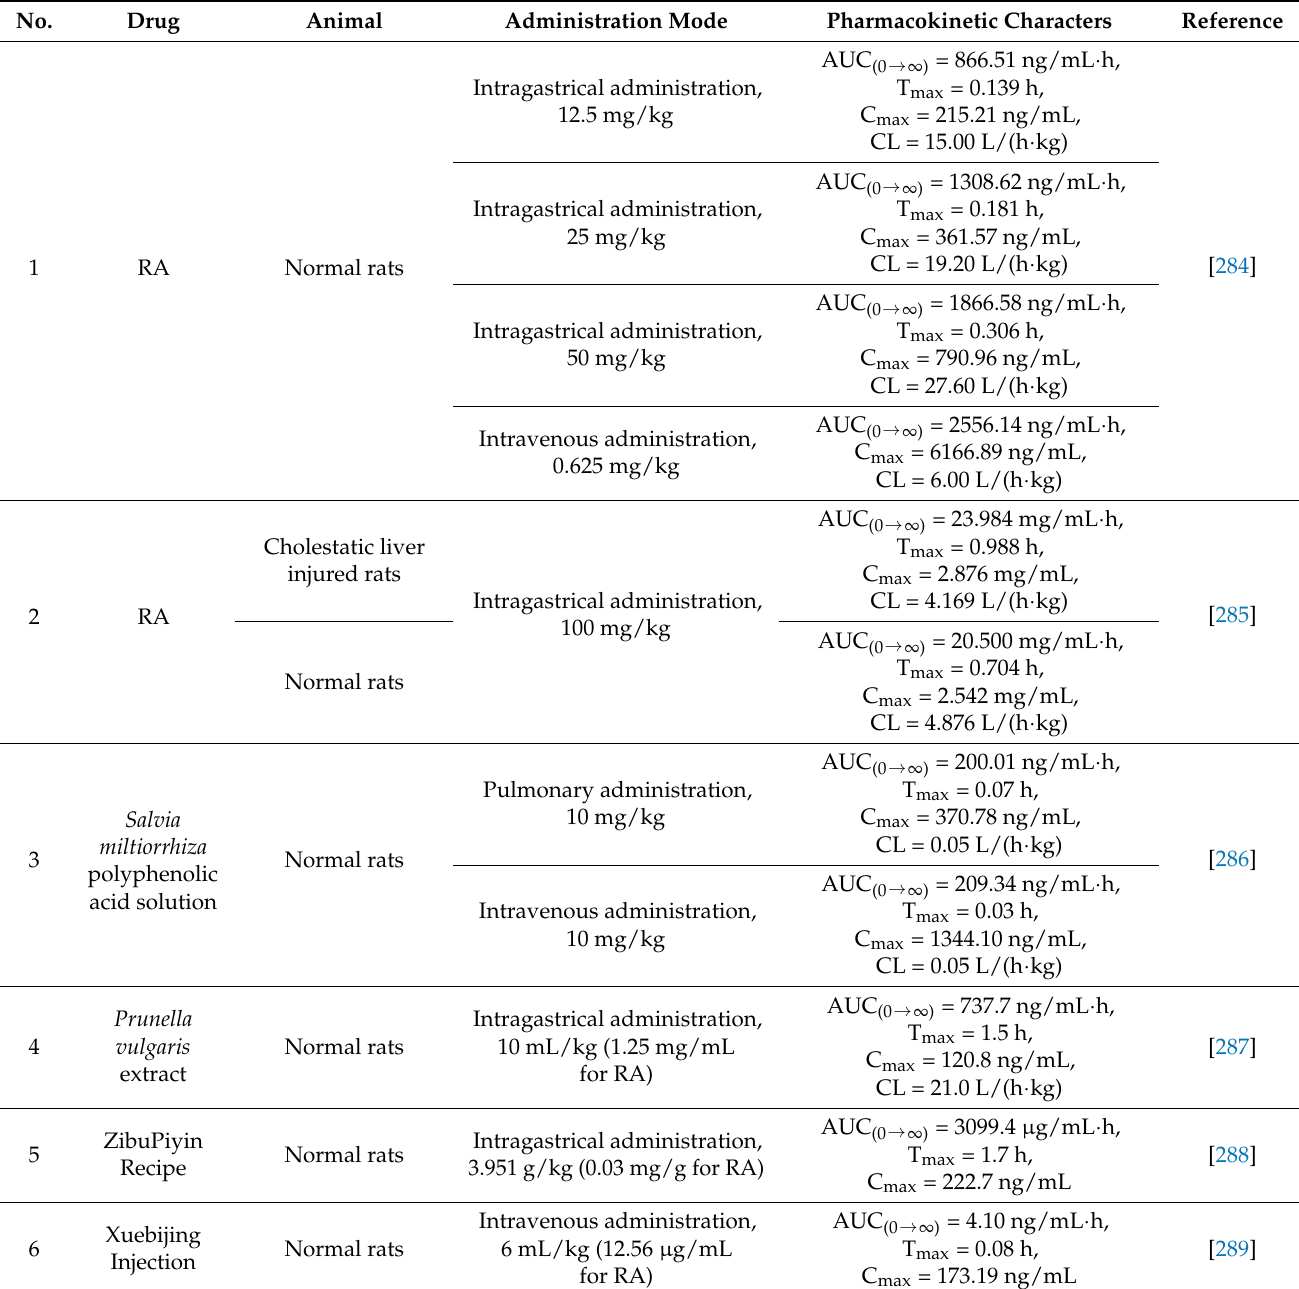
Table 2. The pharmacokinetic characteristics of RA in different test drugs and